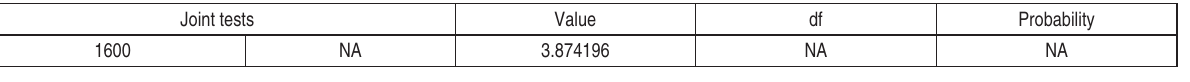
Table 7. Results of the variance ratio test DSE share index daily data